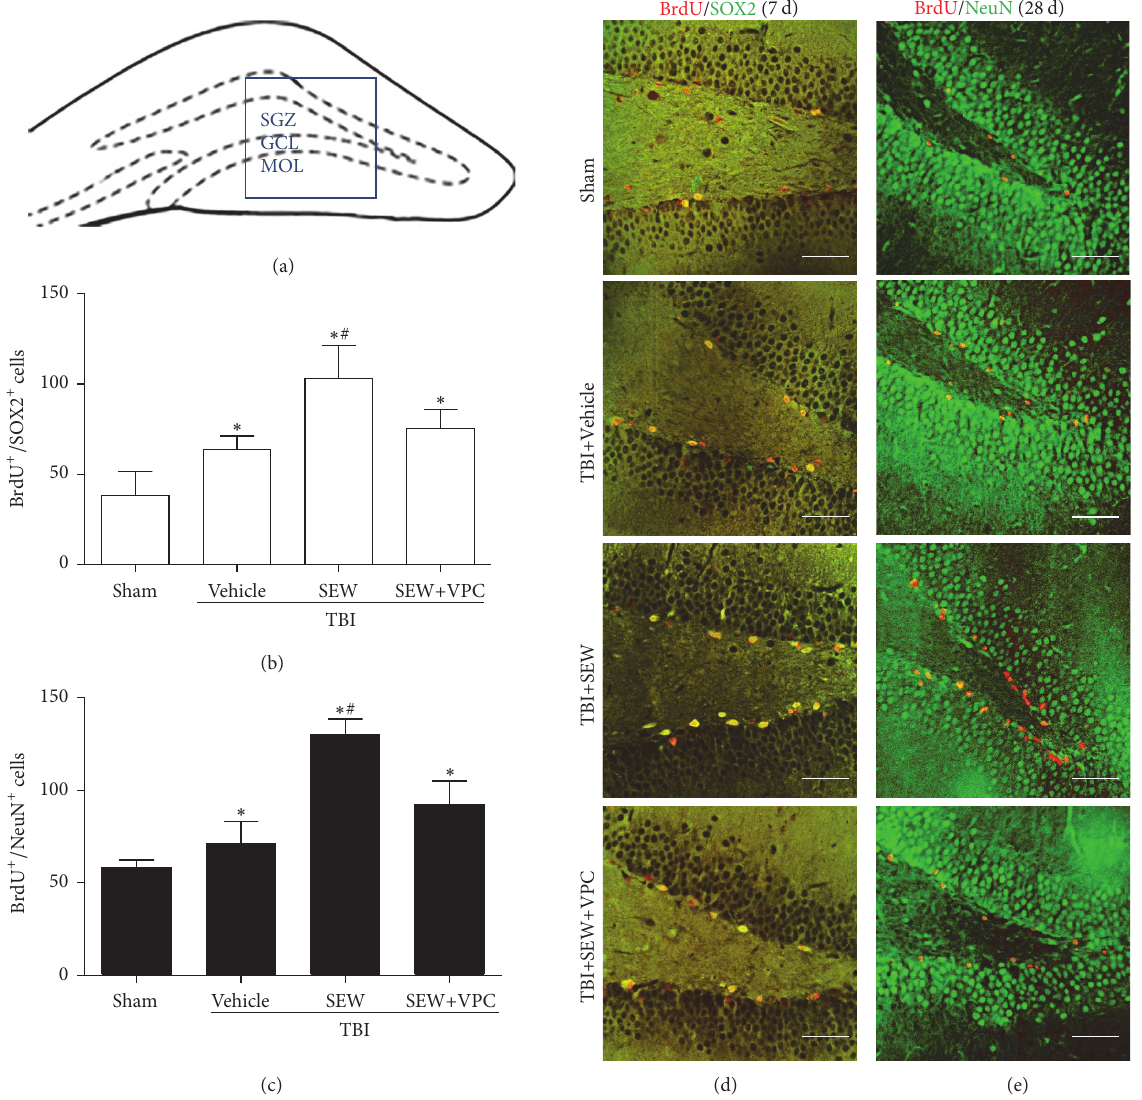
Figure 3: S1PR1 activation enhanced NSCs proliferation and neuronal differentiation in hippocampal dentate gyrus (DG) after TBI. (a) Coronal diagram of rat hippocampus, the subgranular zone, granular cells layer, and molecular layer of DG were, respectively, marked by SGZ, GCL, and MOL, the blue pane representing one of microscopic visual fields for counting immunolabeled cells of immunofluorescence (IF). (b) NSCs proliferation in SGZ at 7 days after TBI was assessed by BrdU/SOX2 double-labeling IF. Quantitation analysis showed that, relative to sham group ( 𝑛 = 3 ), brain injury induced more double-positive cells in TBI+Vehicle group ( 𝑛 = 6 ). Following the treatment of SEW2871, the number of BrdU + /SOX2 + cells further increased in TBI+SEW group ( 𝑛 = 6 ). Reversely, administration of VPC23019 resulted in a significant reduction of BrdU + /SOX2 + cells in TBI+SEW+VPC group ( 𝑛 = 6 ). (c) Neuronal differentiation of NSCs in SGZ at 28 days after TBI was assessed by BrdU/NeuN double-labeling IF. Statistical data indicated that BrdU + /NeuN + cells increased in TBI+Vehicle group ( 𝑛 = 6 ) compared with sham group ( 𝑛 = 3 ). And the double-positive cells increased at even higher level after SEW2871 treatment in TBI+SEW group ( 𝑛 = 6 ). However, VPC23019 administration caused an evident decrease of BrdU + /NeuN + cells in TBI+SEW+VPC group ( 𝑛 = 6 ). (d) and (e) Representative IF microphotographs of hippocampus immunolabeled with BrdU/SOX2 and BrdU/NeuN in all the above four groups at 7 days and 28 days after trauma. Scale bar: 50 𝜇 m. ∗ 𝑃 < 0.05 versus sham group; # 𝑃 < 0.05 versus TBI+Vehicle group or TBI+SEW+VPC